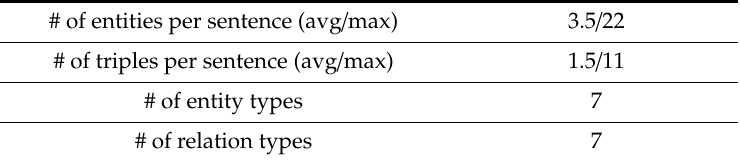
Table 1. Composition of the preprocessed ACE-2005 corpus.